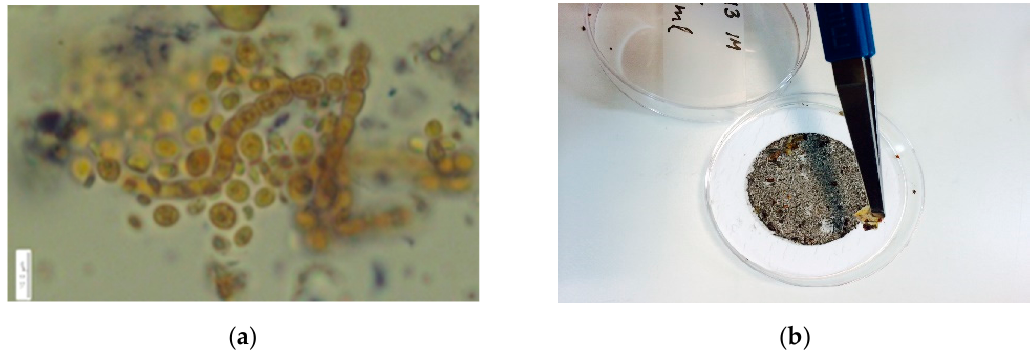
Figure 6. The OC content in Sodankylä snow samples has been found to be partly due to ( a ) algae (photo by Anke Kremp, SYKE, edited by Outi Meinander) pollens and other organisms in the snow, as well as ( b ) trash like needles on the filter (photo by Outi Meinander)